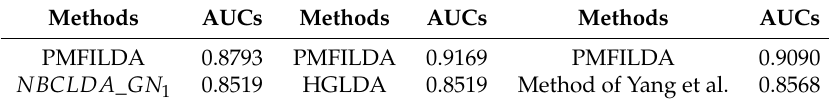
Table 1. Comparison of AUCs of PMFILDA with state-of-the-art